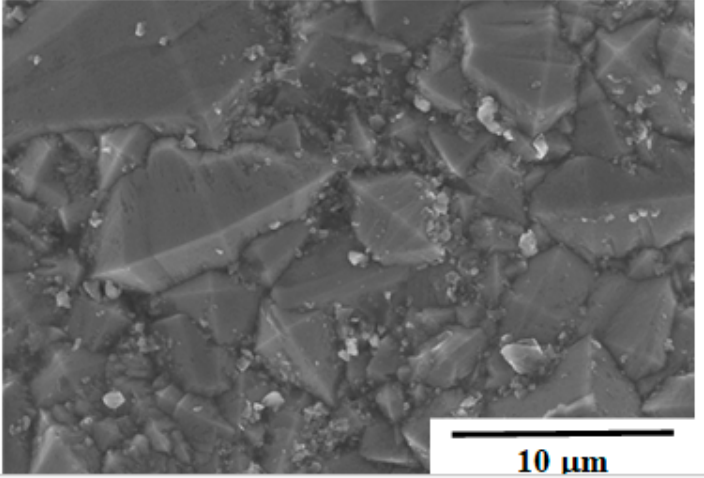
Figure 5. Scanning electron microscopy (SEM) image on the surface of CVD-coated SiC film after buff-polishing.